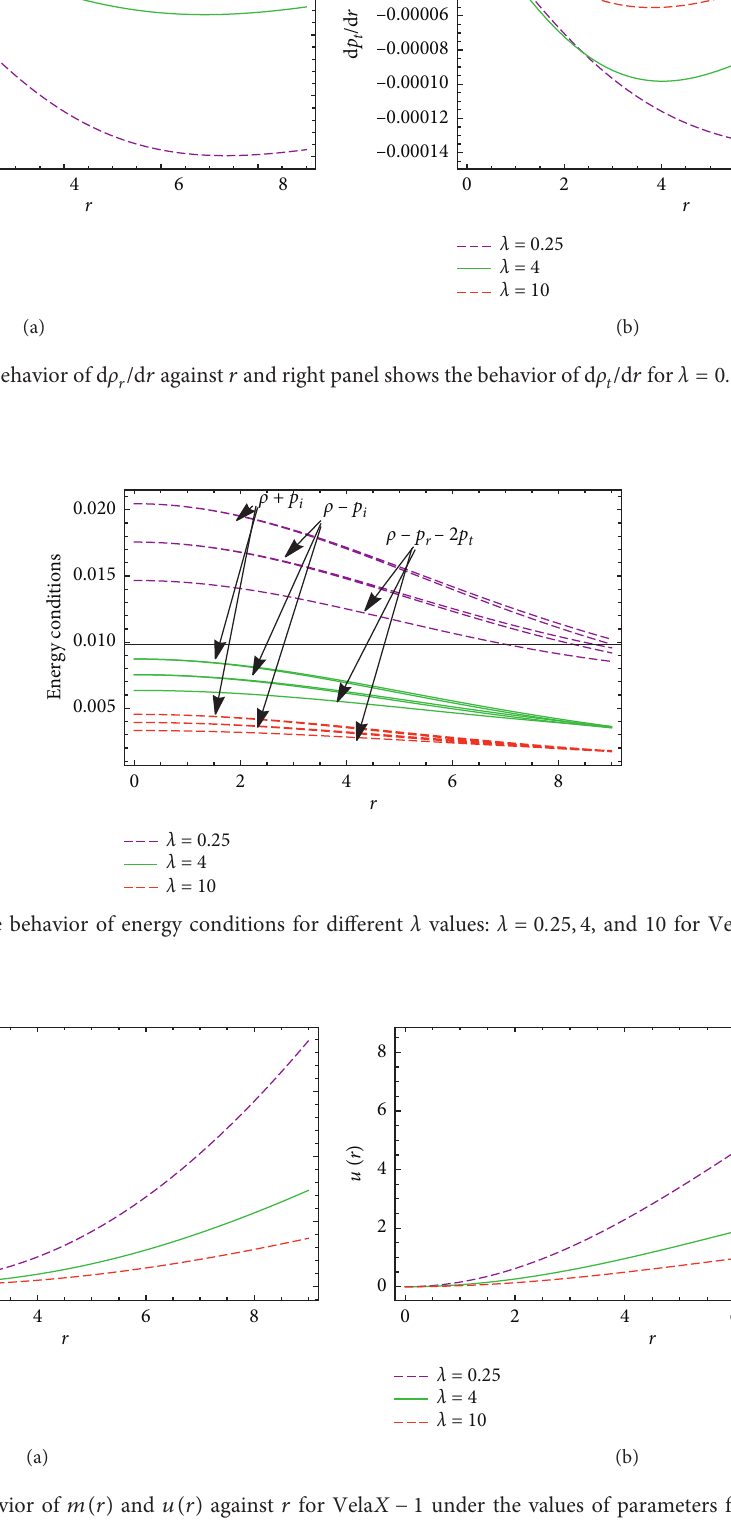
Figure 8: The behavior of m ( r ) and u ( r ) against r for Vela X − 1 under the values of parameters from Table